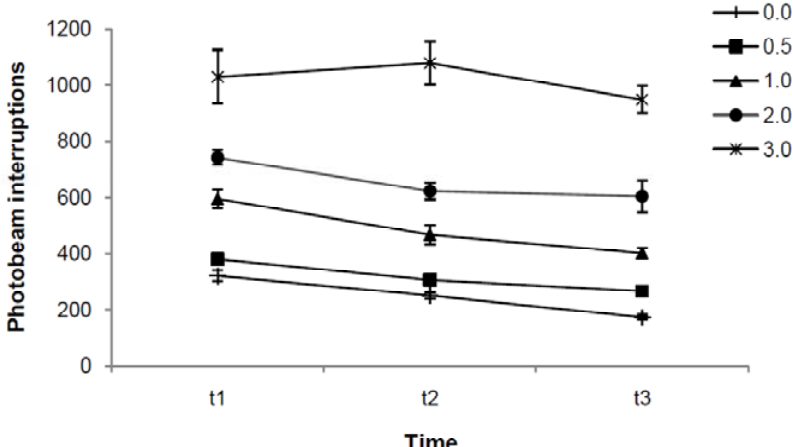
Figure 2. Effect of indatraline on total motor activity. Data represent means (±SE)